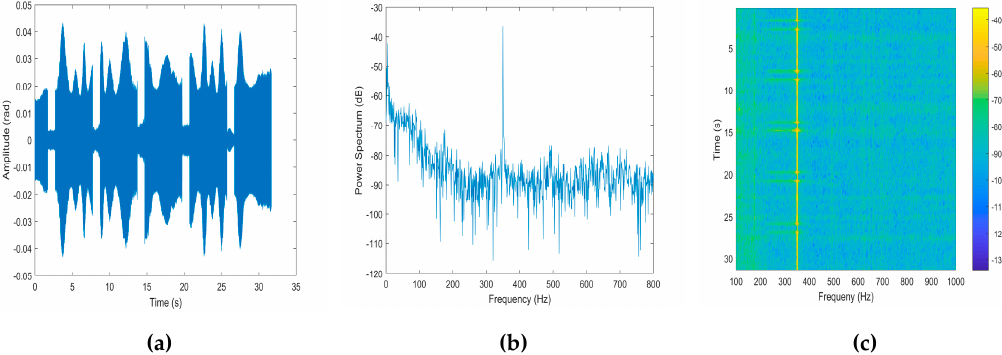
Figure 5. Received signal of the reference element in the direct-arrival zone ( a ) time domain; ( b ) frequency domain; ( c ) time–frequency domain.